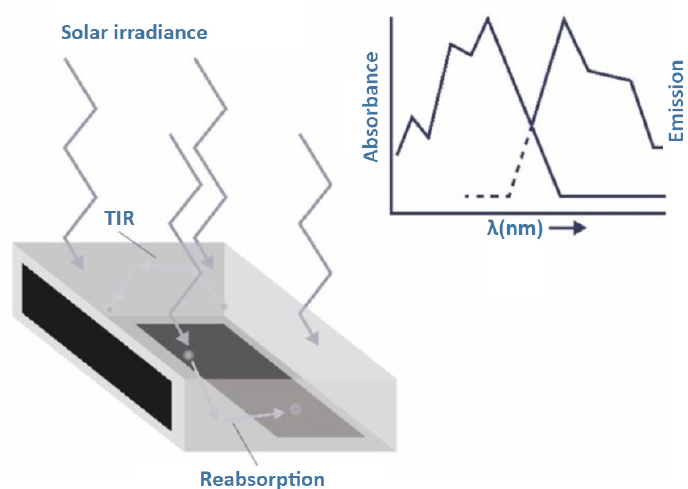
Figure 1. The design and working principle of a luminescent solar concentrator photovoltaic (LSC PV) element, with solar cells attached to the edges, showing the absorption spectrum (solid line) and the emission spectrum (dotted line) of a dye in an LSC.